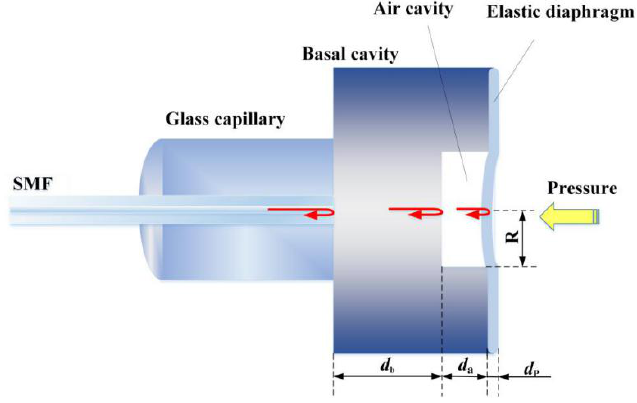
Figure 1. Schematic diagram of a typical EPFI sapphire pressure sensor.